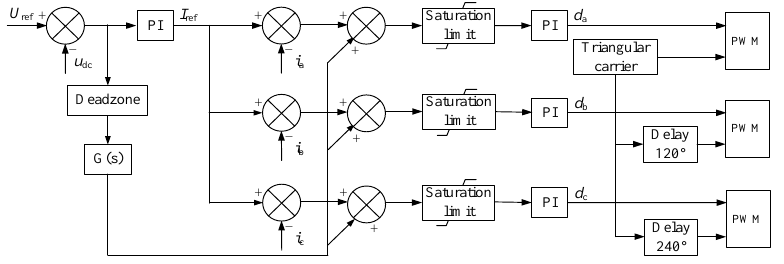
Figure 6. The dual-loop constant voltage PI control with feed-forward.